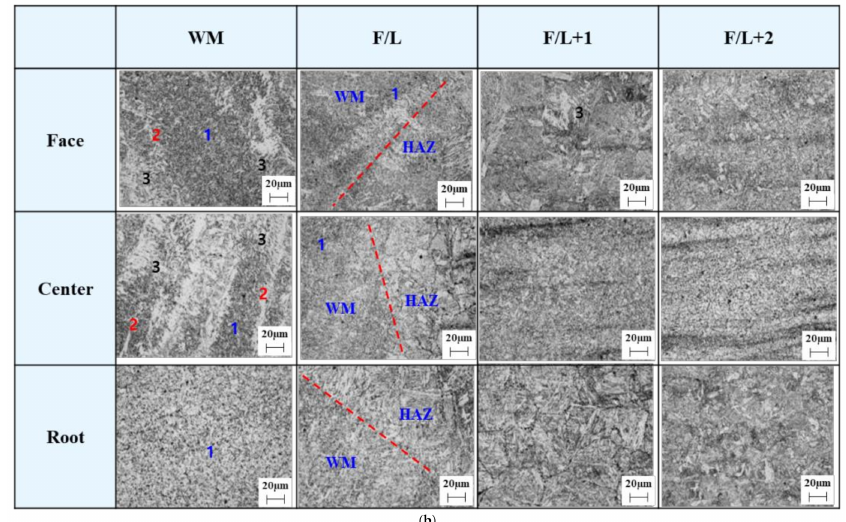
Figure 5. Microstructures of the weldment after removal of the run-off plate: ( a ) SAW (B1) and ( b ) FCAW